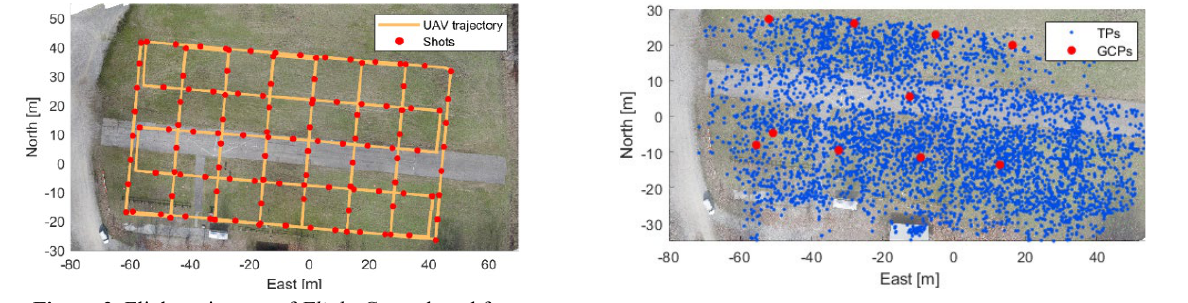
Figure 4. Tie Points (TPs) and GCPs used in the block simulation.